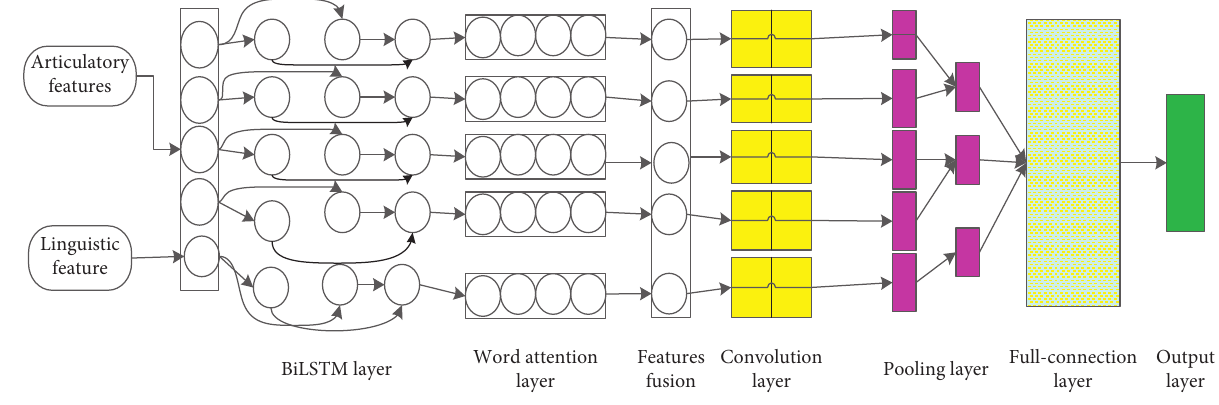
Figure 3: Integration model of BiLSTM-CNN.